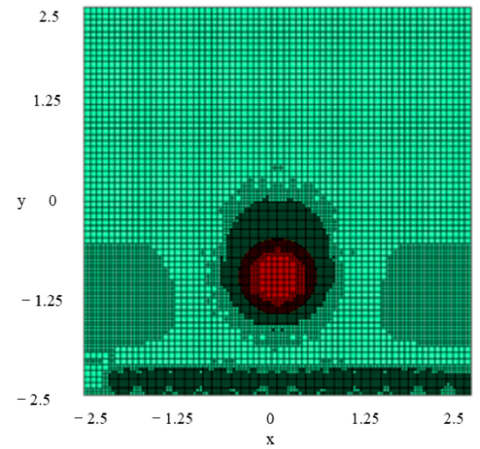
Figure 3. Schematic diagram of fine mesh.